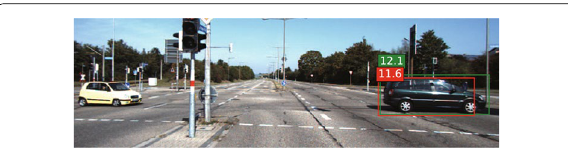
Fig. 1 Examples of the relation between the appearance of target objects (cars), and those distance in KITTI dataset. The green and red rectangles are the ground truth (GT) and estimated bounding boxes (by our proposed method) respectively. The values in green and red boxes are the GT and estimated distances respectively in meter. The distance of the car on the right hand side is 12.1 m